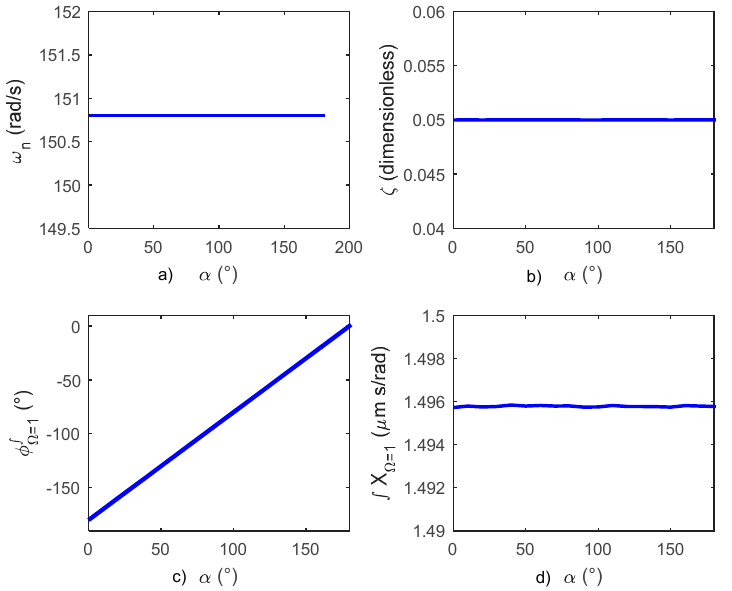
Figure 7. Characteristic patterns of close modes in frequency considering ∆ ω = 0% for ( a ) natural frequency, ( b ) damping ratio, ( c ) phase angle and ( d ) vibration amplitude at resonance.